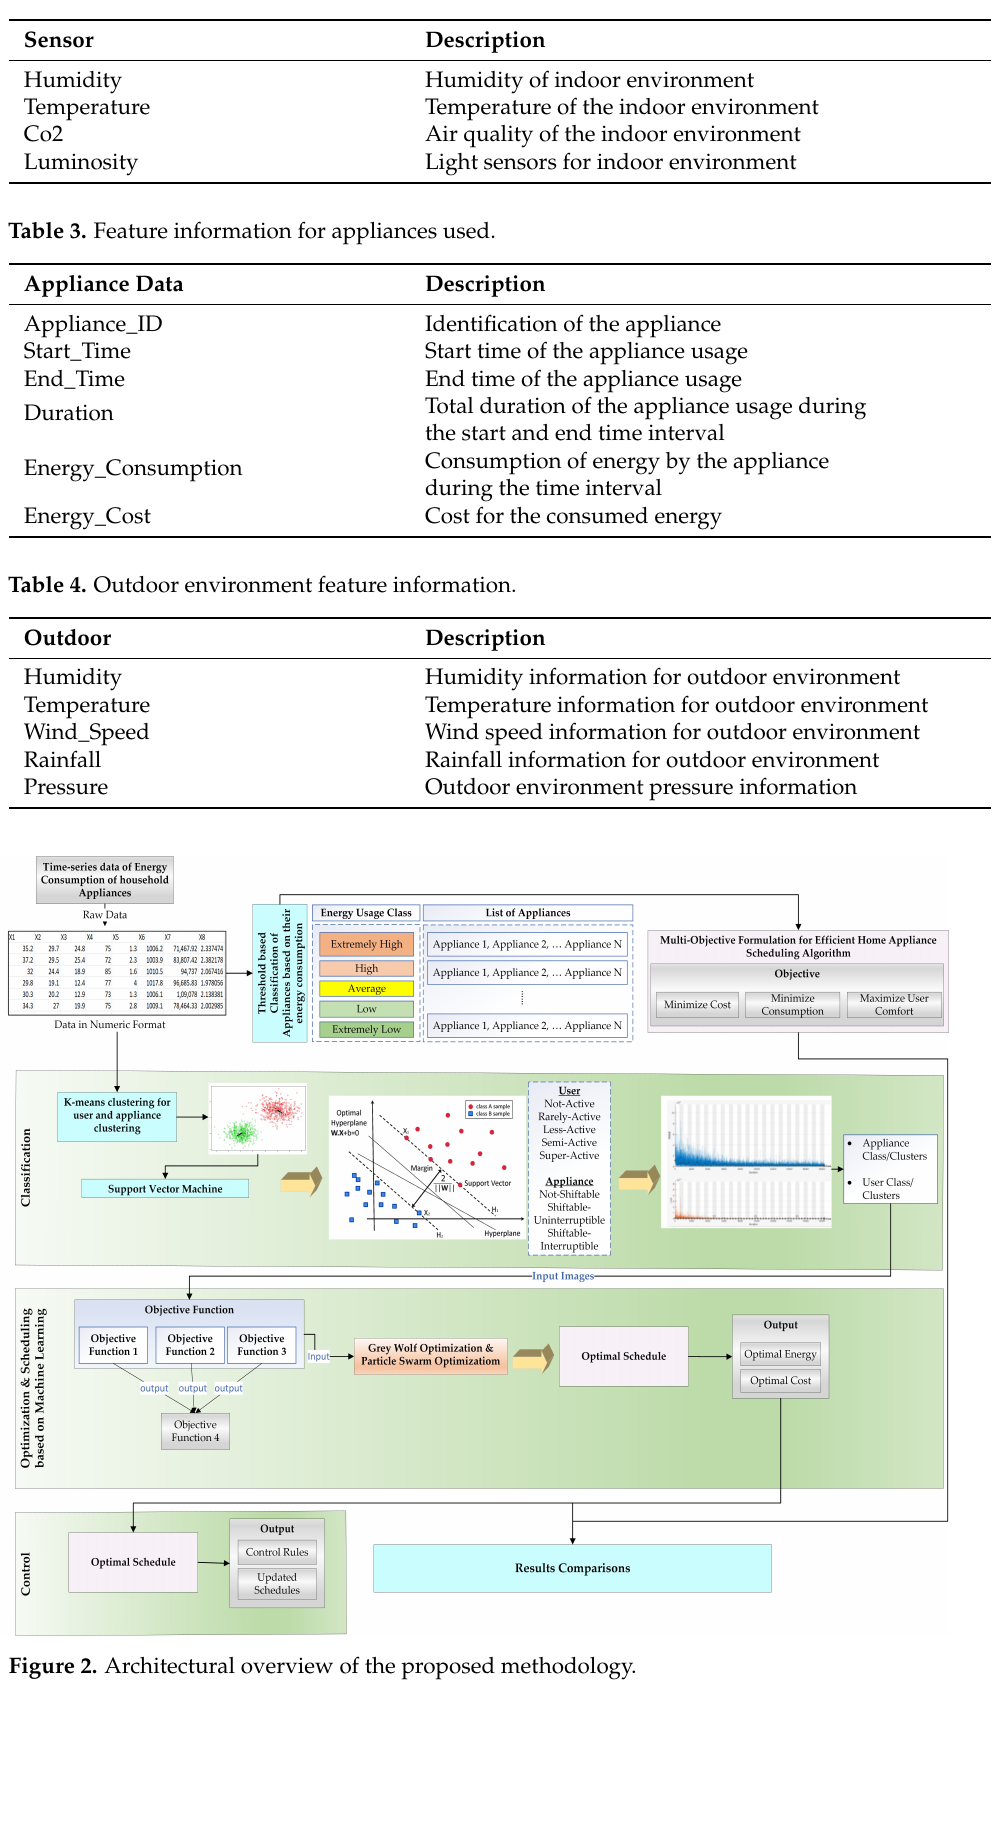
Table 2. Sensor data feature information for the indoor environment.